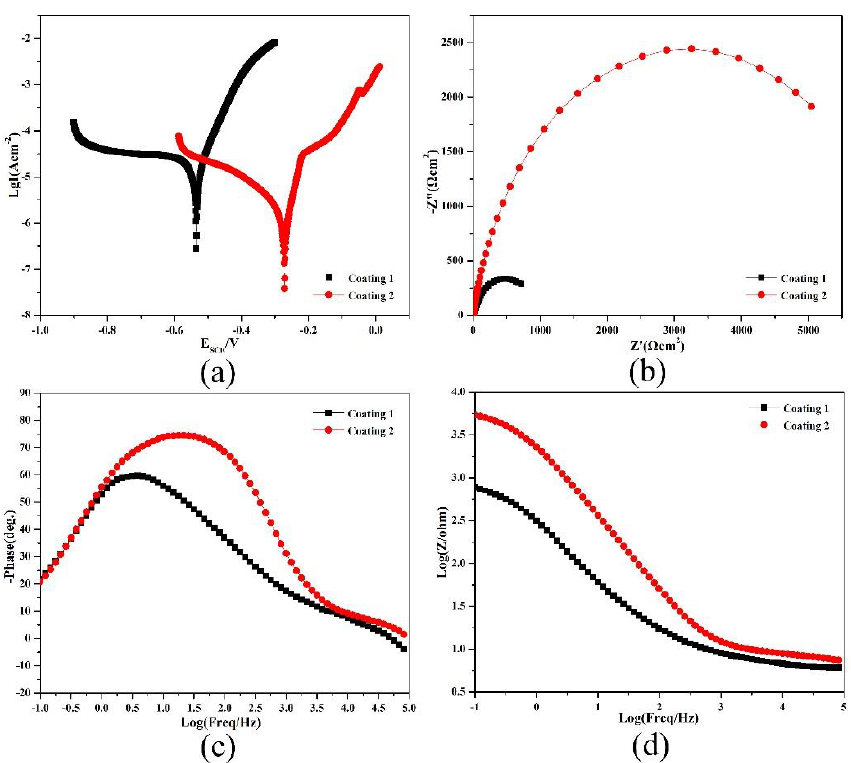
Figure 15. The curves of electrochemical tests: ( a ) anodic polarization curves; ( b ) Nyquist plots; ( c,d ) Bode plots. Table 5. Fitting results of polarization curves.